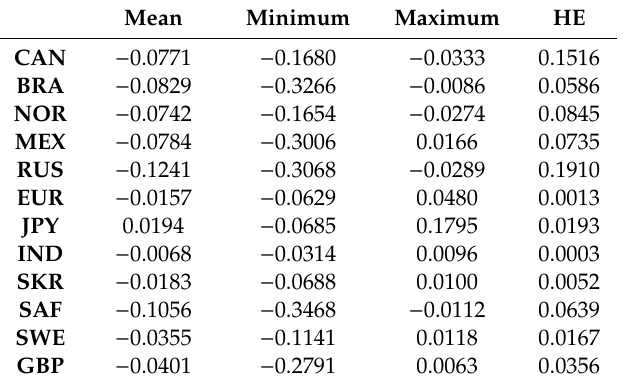
Table 3. Summary statistics for hedge e ff ectiveness (HE) and hedge